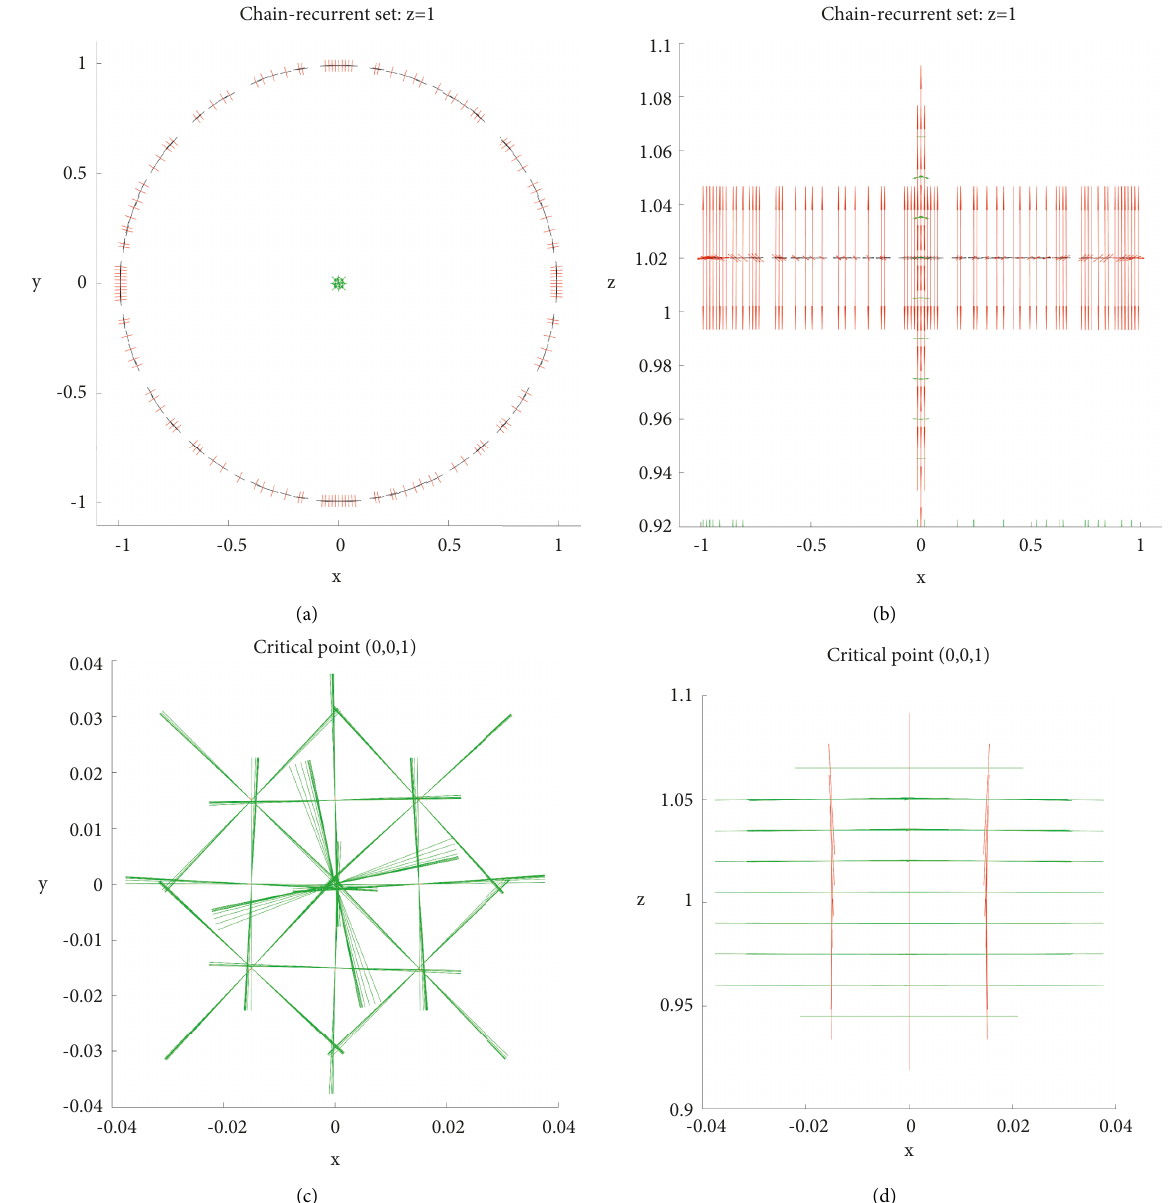
Figure 12: System (21). z � 1, periodic orbit Ω and equilibrium at ( 0 , 0 , 1 ) in the xy -plane (a) and in the xz -plane (b). Ω 1 dimensional unstable manifold (in z -direction and towards the equilibrium). Equilibrium ( 0 , 0 , 1 ) in the xy -plane (c) and in the xz -plane (d). Two-dimensional stable manifold (in xy -plane) and one-dimensional unstable manifold (in z